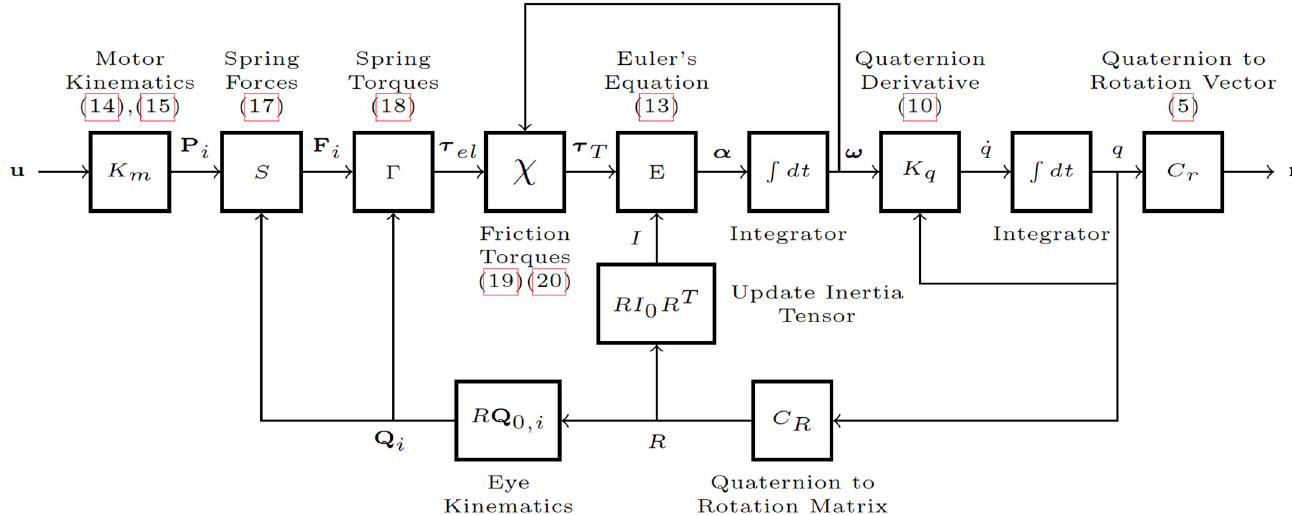
Fig 6. Block diagram of 3D eye saccade simulator. Close to each block is a summary description and the equation numbers that implement the associated functions (when applicable).